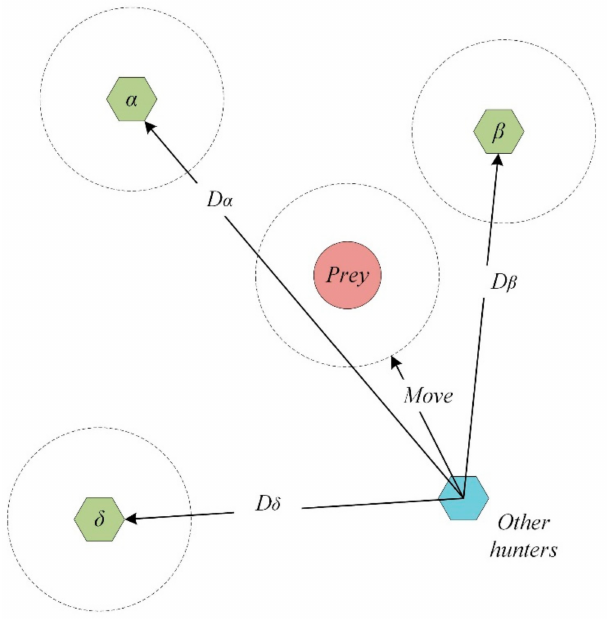
Figure 3. Updating positions in the grey wolf optimizer